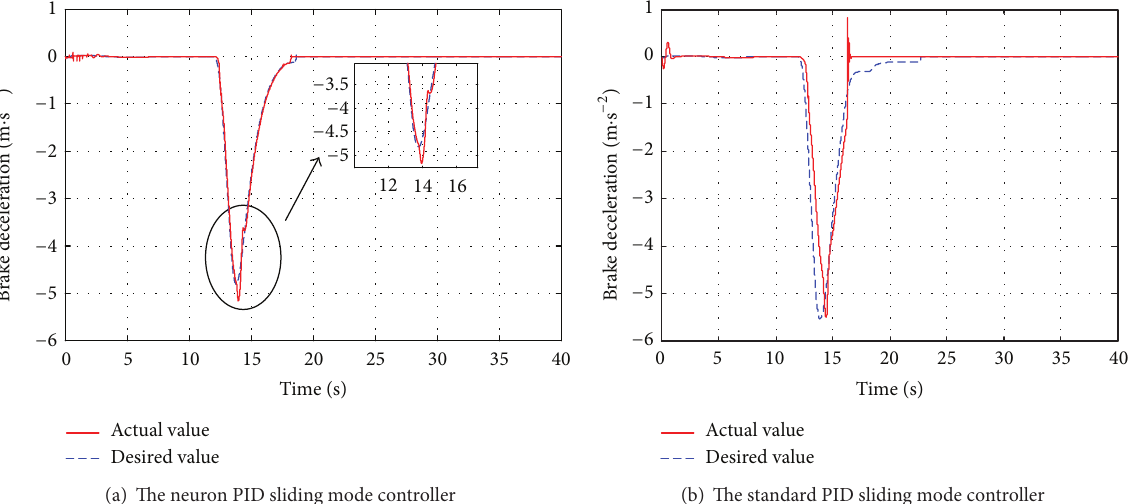
Figure 6: The vehicle deceleration.